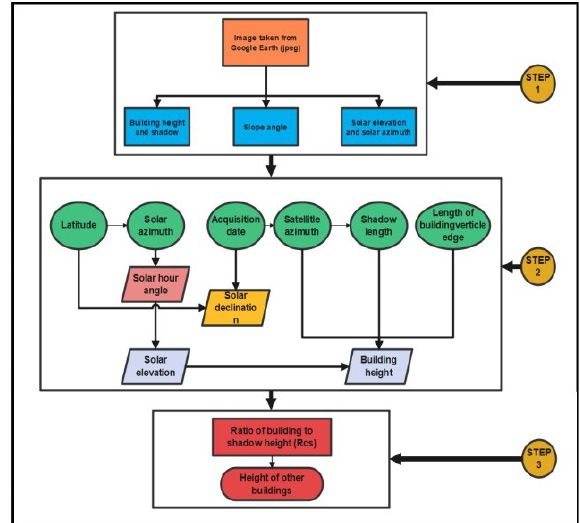
Figure 2. Flowchart of building height